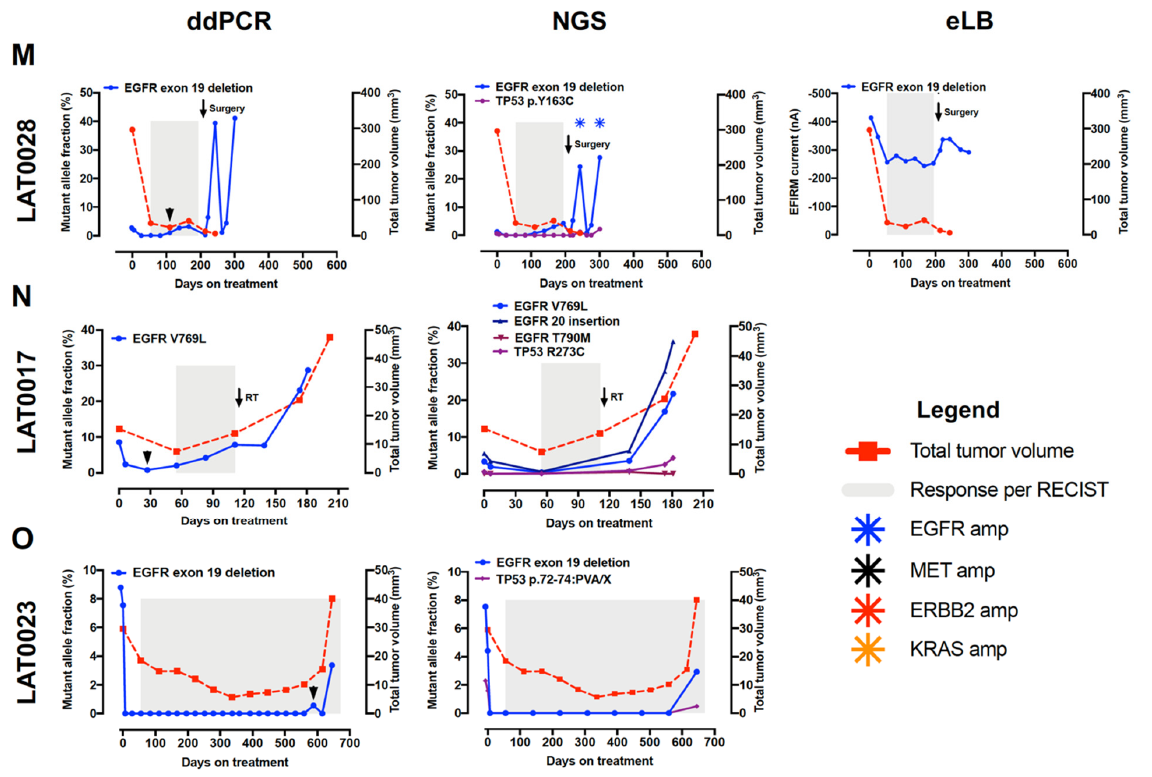
Figure 4. (A-O) Serial monitoring of ctDNA by ddPCR, NGS, and eLB for prediction of response and the detection of emergence of resistance. Solid lines represent genomic alterations and red dotted lines represent calculated tumor volume measured by volumetric CT measurement. AFs for ddPCR and NGS and current values for eLB are plotted on the left y -axis. Calculated tumor volume measured by volumetric CT measurement is plotted on the right T-axis. Treatment duration is plotted on the x-axis. The shaded gray areas indicate the duration of RECIST 1.1 response (complete or partial response). ctDNA progression, defined as increases in mutant EGFR AF by ddPCR, preceded RECIST 1.1 progression by a median of 118 days (range: 61–272 days) in 11 patients (LAT001, 002, 003, 005, 010, 013, 014, 015, 017, 023, 028). Of the 10 patients without ctDNA progression by ddPCR, 2 patients had an increase in EGFR mutation-level by eLB (LAT006, LAT026), 1 patient had an increase in the AF of PTEN Y88* by NGS (LAT007), and another patient had an increase in TP53 V157F by NGS (LAT016). The arrowhead (in black) indicates the beginning of ctDNA progression.